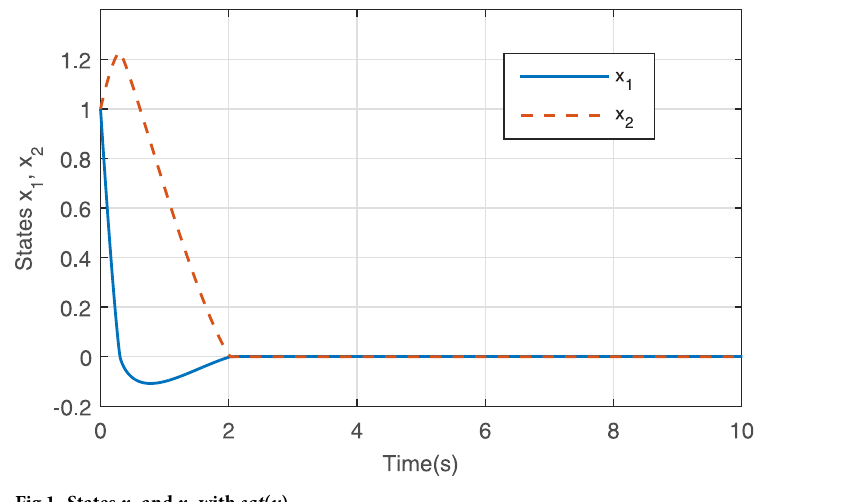
Fig 1. States x 1 and x 2 with sat ( u ).